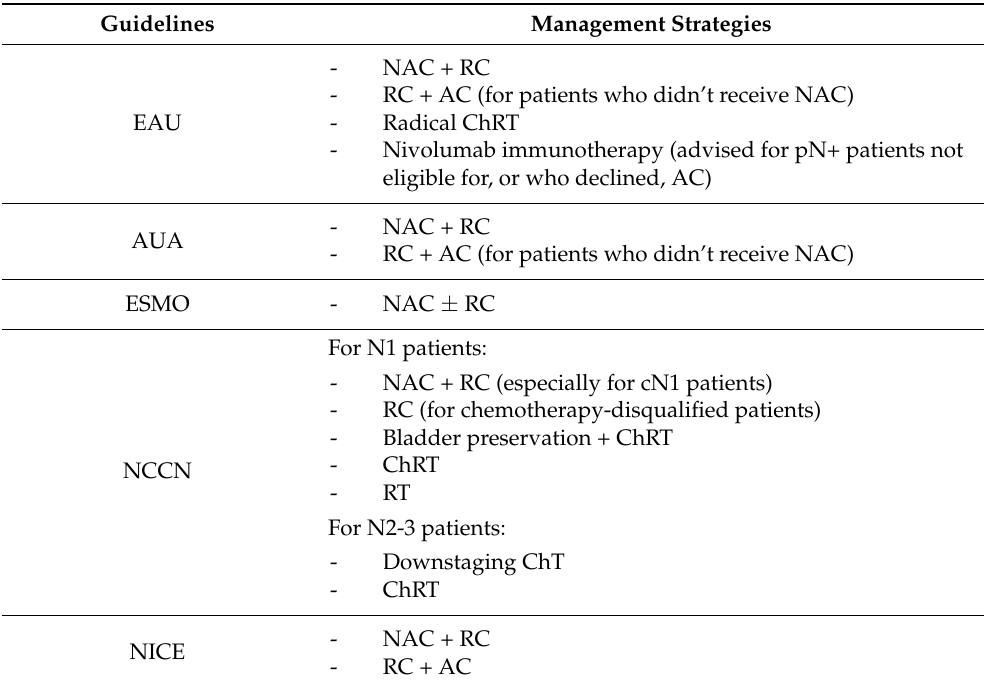
Table 2. Overview of cN+ patients’ management strategies according to guidelines provided by the EAU, the AUA, the ESMO, the NCCN, and the